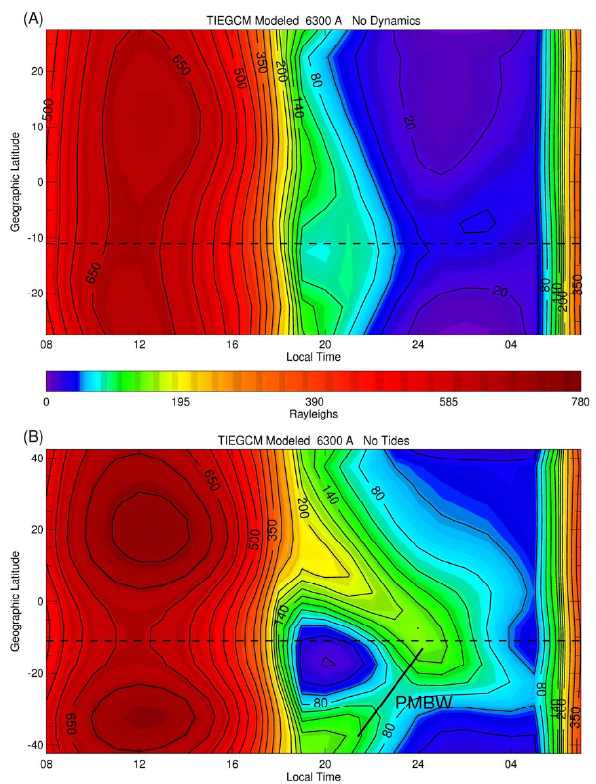
Figure 8. Fig. 8. (A) Modeled 6300 ˚A emissions with TIEGCM without the inclusion of the pre-reversal enhancement. (B) Modeled 6300 ˚A emissions without the inclusion of upward propagating tides within TIEGCM. The PMBW and its equatorward propagation are indi- cated by the solid black line. In both panels, the dashed line indi- cates the position of the geomagnetic equator.